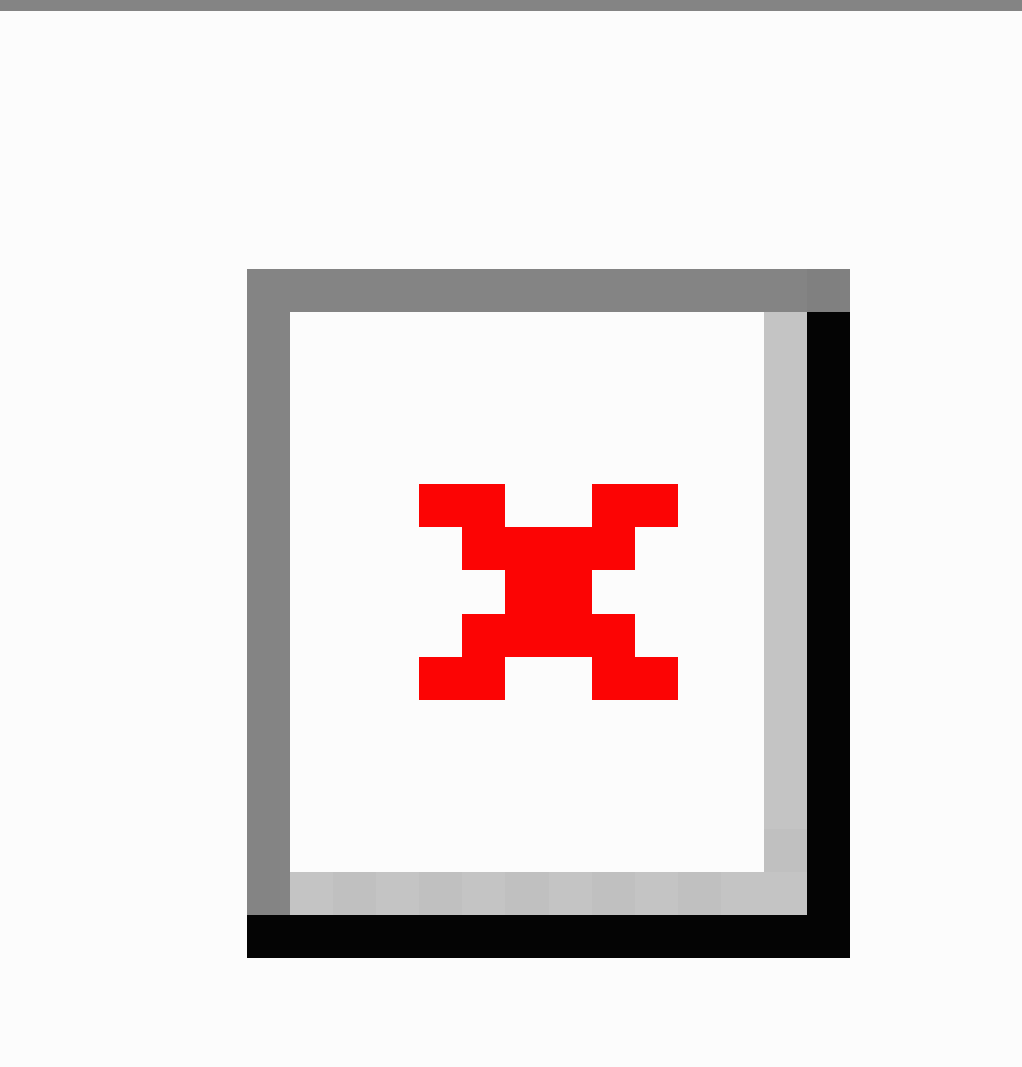
Figure 3. Box plots of the hearing results of right ears and left ears obtained from the Ear Scale app in relation to those obtained from pure-tone screening. The box includes the median (heavy line) and represents the first and third quartiles, whereas the vertical bar indicates the SD. Blue lines represent best-fit linear regressions of the means of the boxes, whereas the gray areas around the line represent the 95% CI of the model (P<.05, differences were found between groups). S: stratified hearing